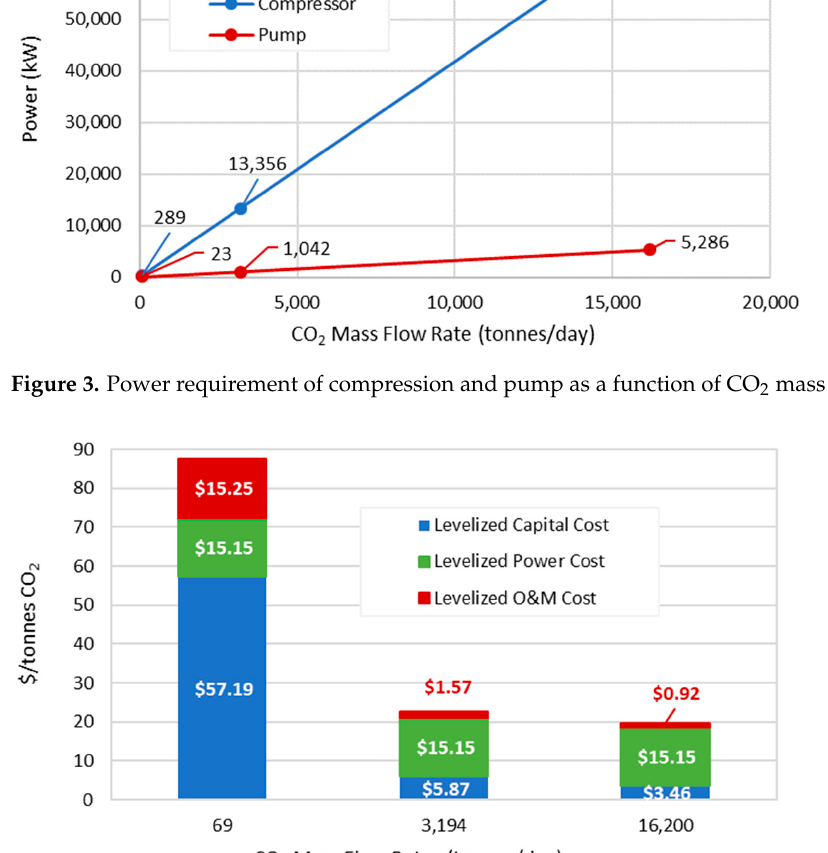
Figure 3. Power requirement of compression and pump as a function of CO 2 mass flow rate.